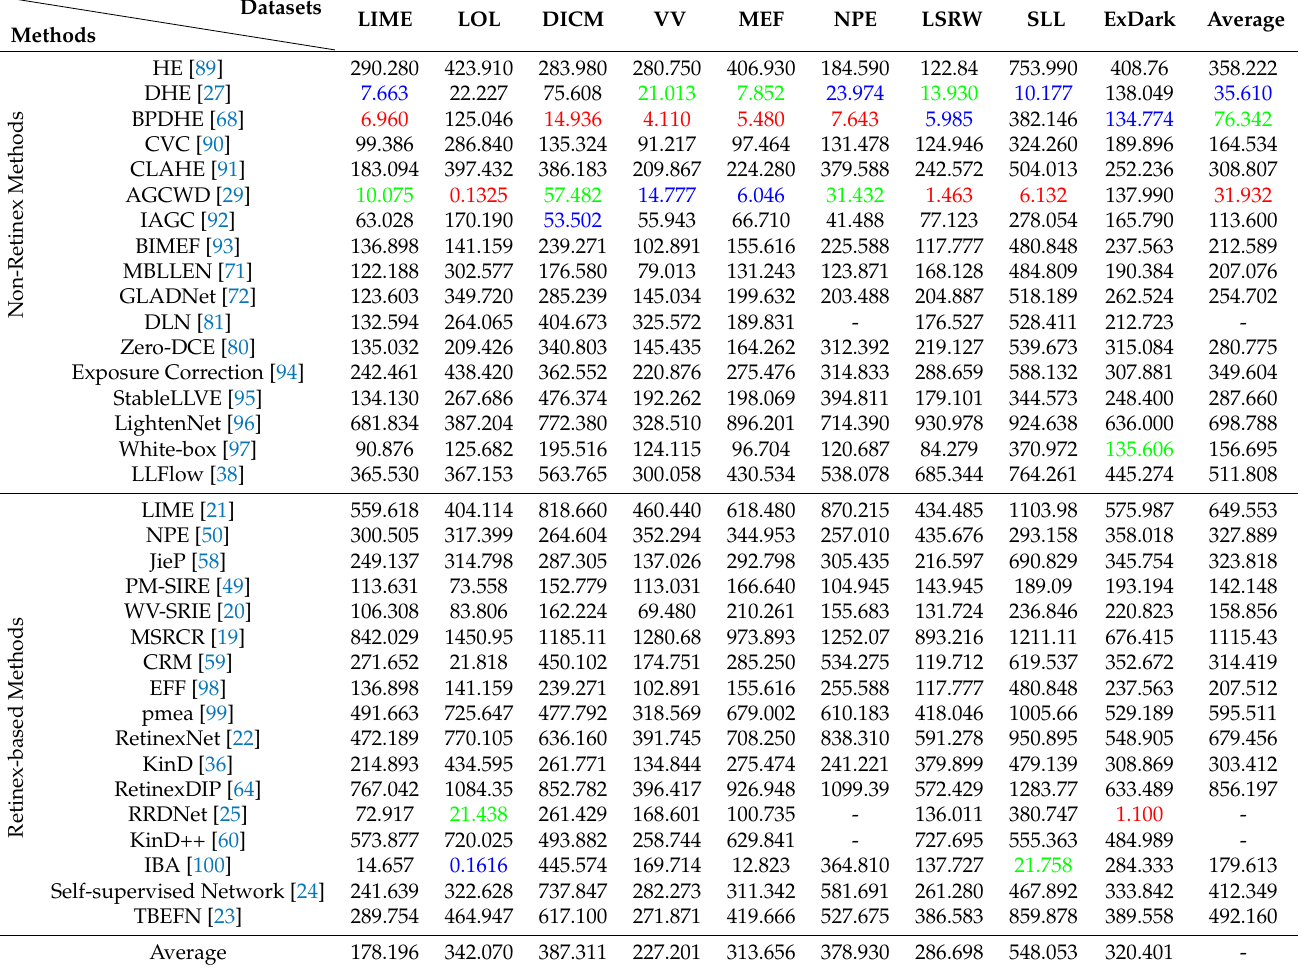
Table 1. Quantitative comparison of enhancement algorithms on nine test datasets using LOE metric. A lower value of the LOE metric indicates better performance. The first, second, and third best scores are highlighted with red, blue, and green colors,